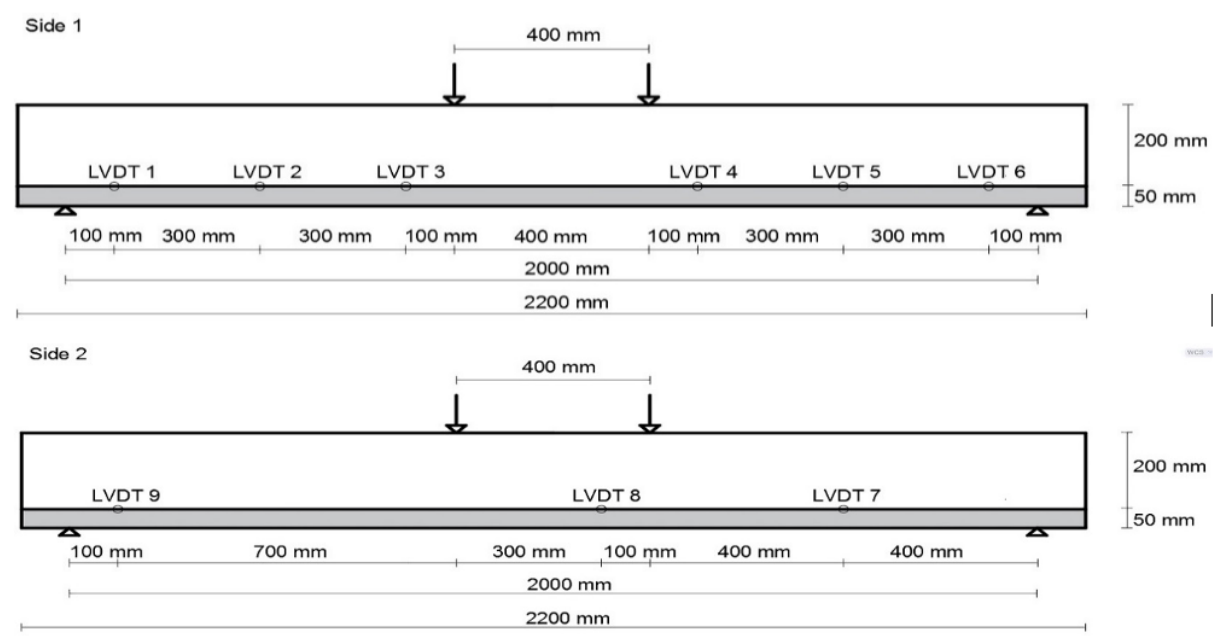
Figure 6. a) LVDTs on side 1 b) LVDTs on side